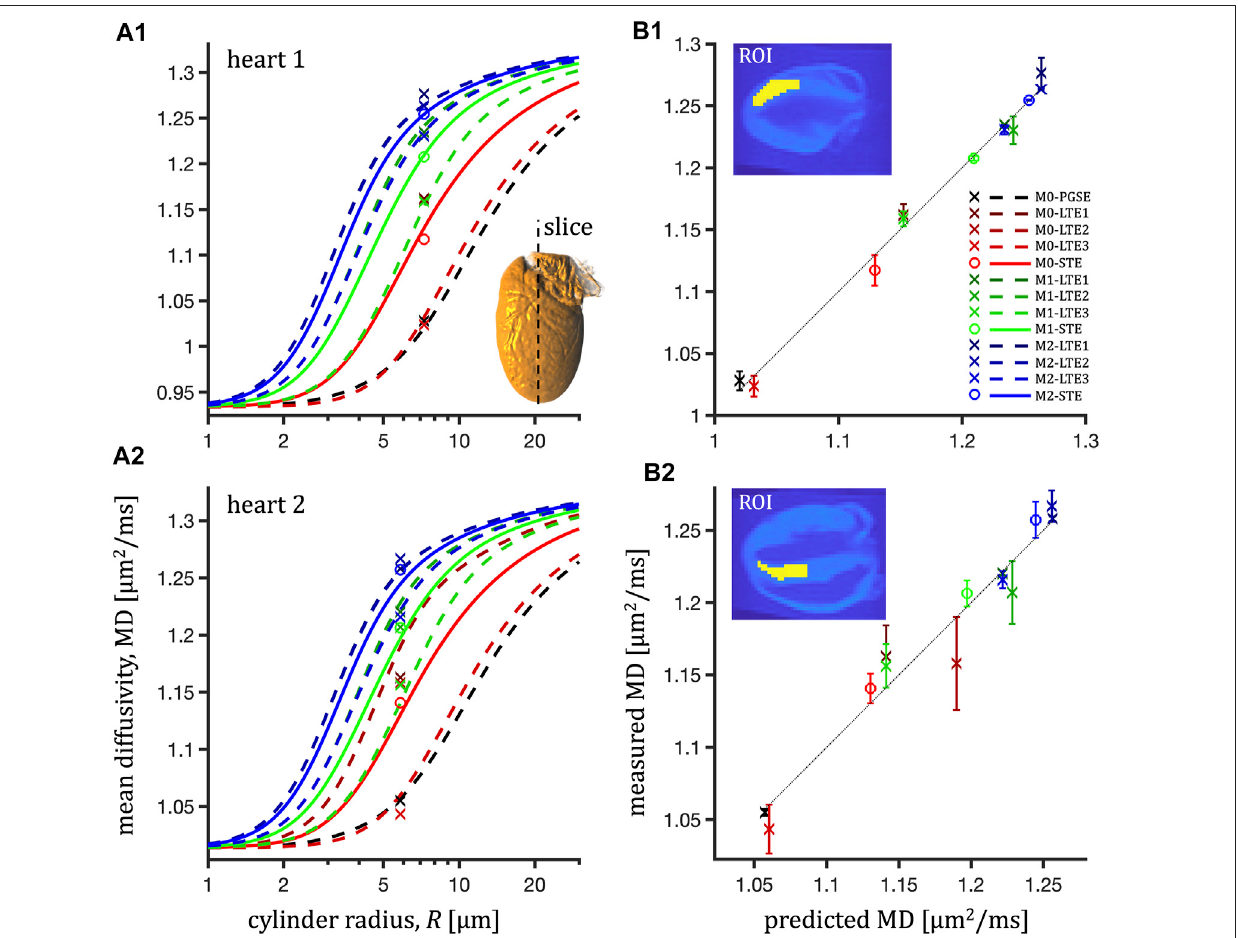
FIGURE4| ROI-averagemeandiffusivityintheleftventriclemyocardiuminthecentralslice(long-axisview)oftwomousehearts(1-top,2-bottom)andpredictionof the hindered-restricted model. Left column (A1,A2) : measured MD (markers) and prediction (lines) vs. cylinder radius, R . Right column (B1,B2) : measured MD vs. prediction with error bars corresponding to the distance between measurement and prediction (dotted line for unity relation). For every degree of motion compensation (M0, M1, M2), the LTE waveforms correspond to the X,Y,Z channels of the STE waveforms.